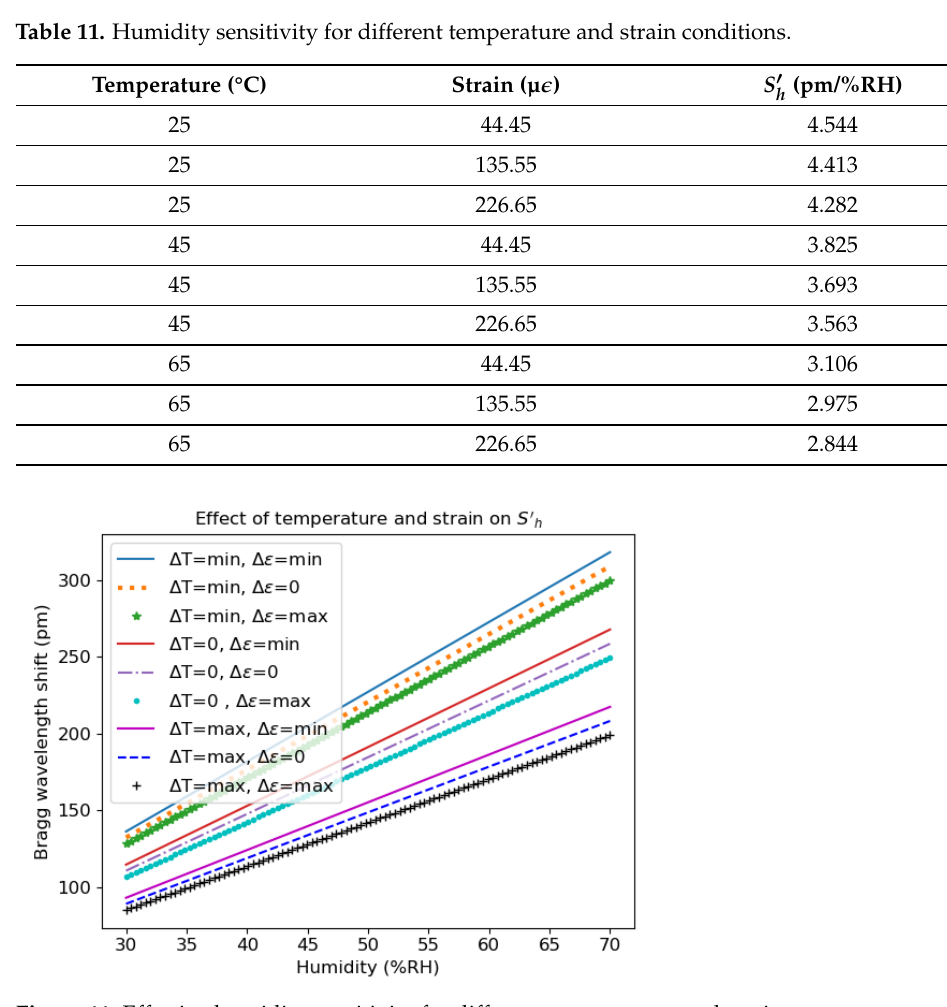
Figure 11. Effective humidity sensitivity for different temperatures and